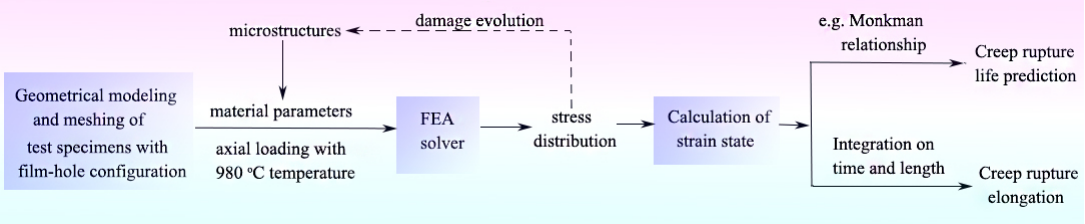
Figure 3. Progressive simulation of microstructure evolution and mechanical behavior of DD6 specimens with different film-hole configurations (FEA: Finite element